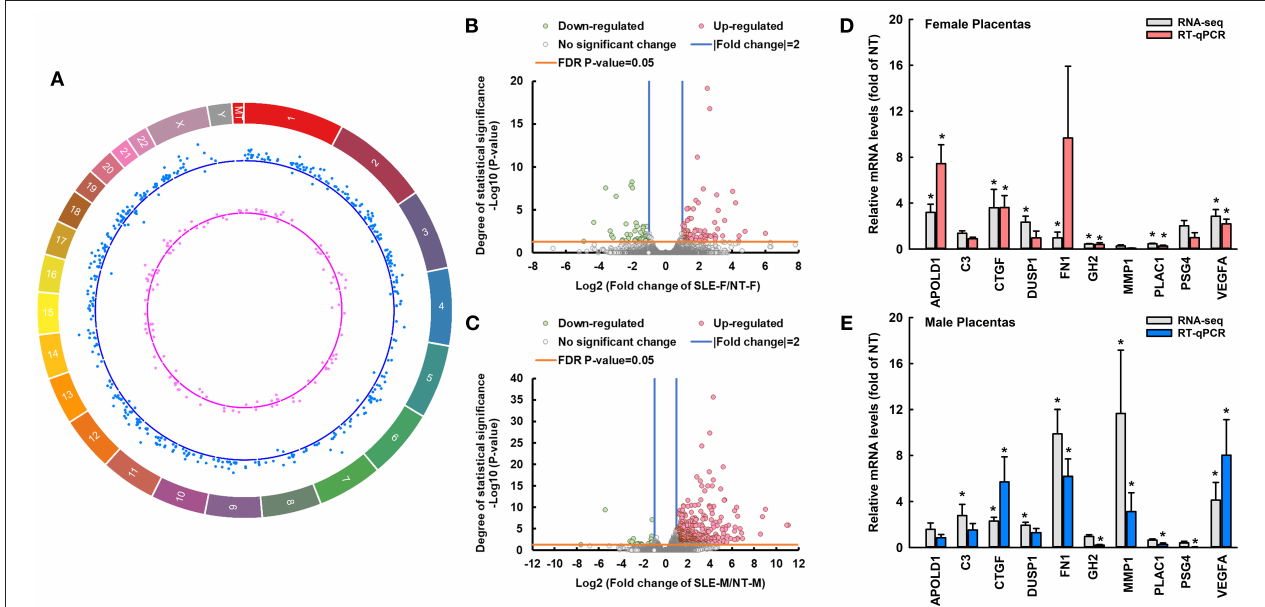
FIGURE 1 | SLE differentially dysregulates transcriptomic profiles of female and male placentas. (A) Circos plot illustrating the chromosome location of differentially expressed protein-coding genes between SLE-F vs. NT-F (pink dots) and SLE-M vs. NT-M (blue dots). Each dot represents one differentially expressed gene. The letters and numbers in the outer layer represent the chromosome location. For the scatter plot tracks, dots outside and inside of the centerline represent upregulated and downregulated genes, respectively. (B,C) Volcano plots showing differentially expressed genes between SLE-F vs. NT-F, and SLE-M vs. NT-M in RNA-seq. Gray dots: no significant difference; pink and green dots: > two-fold upregulation and downregulation, respectively (FDR-adjusted P -value < 0.05) in SLE vs. NT; n = 3-5/group. (D,E) RT-qPCR validation of SLE-dysregulated genes in female and male placentas. * P < 0.05 vs. NT, n = 4/group. MT, mitochondrial DNA; SLE, systemic lupus erythematosus; APOLD1, apolipoprotein L domain containing 1; C3, complement C3; CTGF, connective tissue growth factor; DUSP1, dual specificity phosphatase 1; GH2, growth hormone 2; PLAC1, placenta specific 1; FN1, fibronectin 1; PSG4, pregnancy-specific beta-1-glycoprotein 4; VEGFA, vascular endothelial growth factor A; MMP1, matrix metallopeptidase 1. RNA-seq, RNA sequencing; FDR, false discovery rate. Circos plot showing the location DE-genes was generated using circa software for